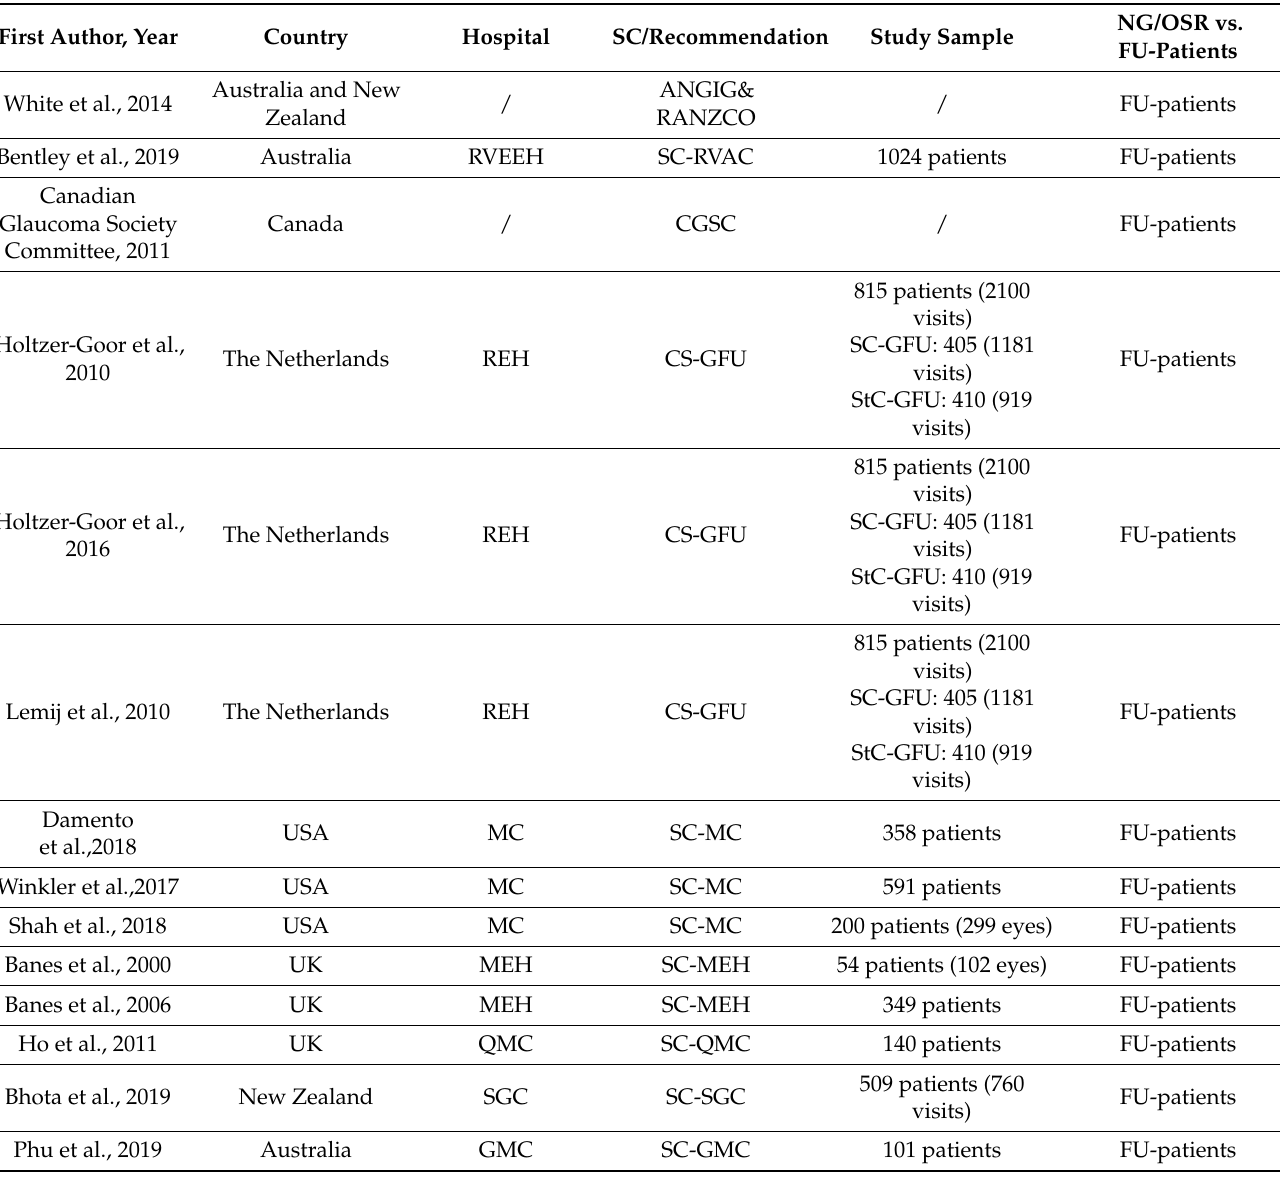
Table 1. Baseline Characteristics “Shared